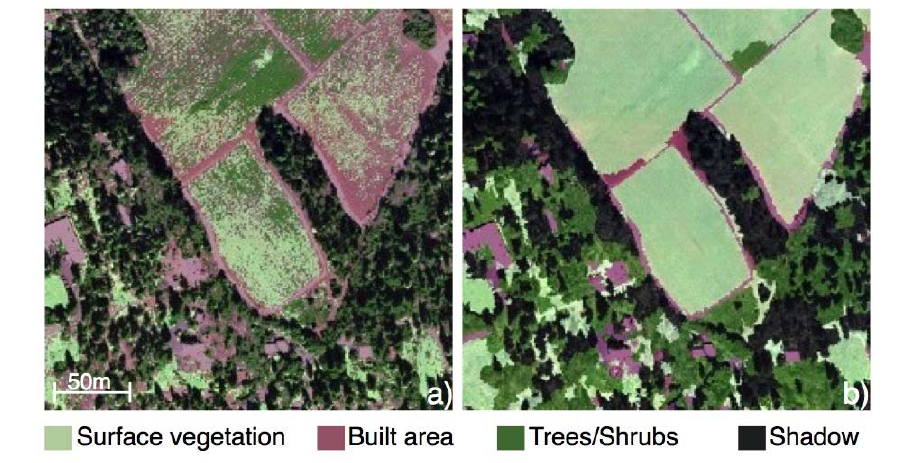
Figure 1. Example of the speckle, or the “salt-and-pepper” effect common to pixel-based classifications of fine spatial resolution imagery: (a) an unsupervised classification of land cover from a suburban area in California; (b) the same area classified with an object-based classifier.